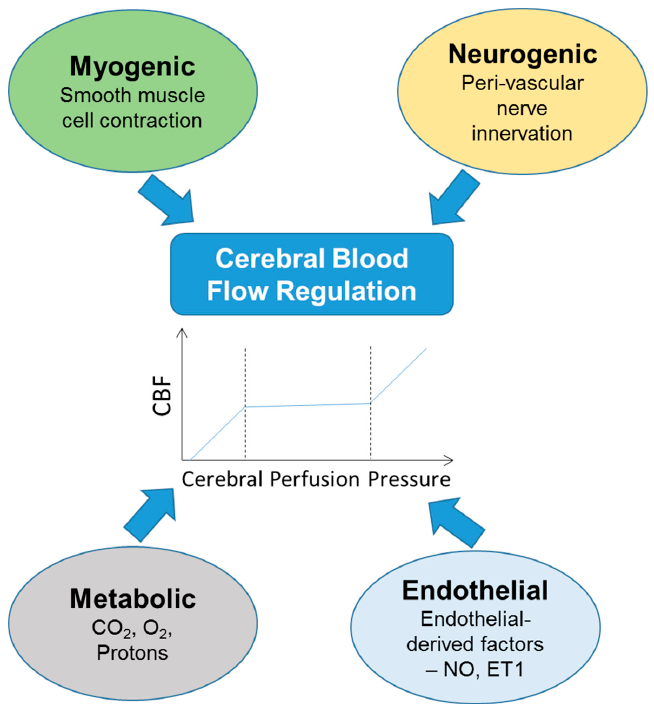
Figure 1. Cerebral blood flow can be regulated by four major mechanisms: myogenic, neurogenic, metabolic, or endothelial. These mechanisms ensure that cerebral blood flow (CBF) is maintained within a relatively normal range. NO—nitric oxide, ET1—endothelin 1.